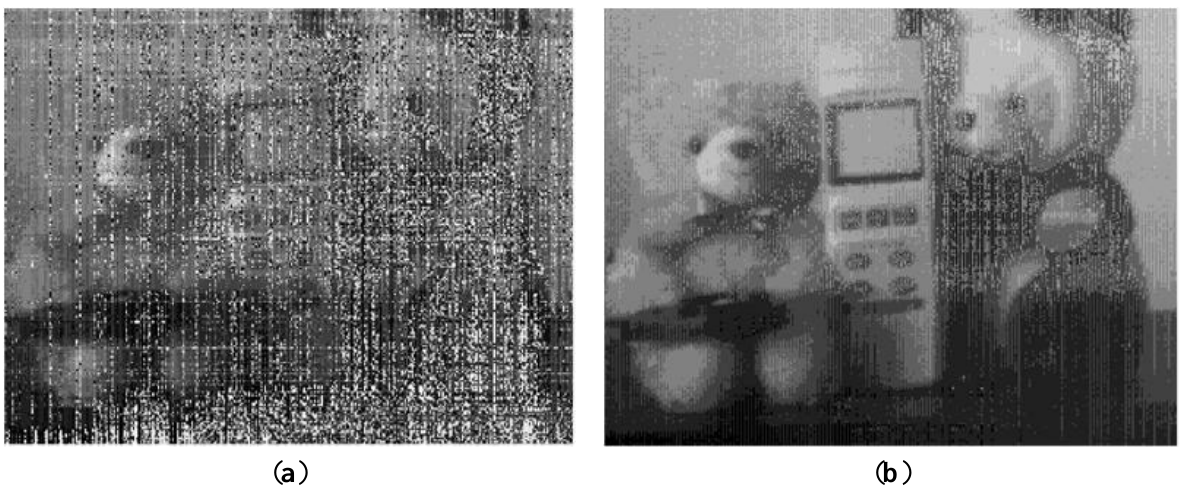
Figure 16. Measured sample image with the 1-bit coarse and 7-bit fine (14-bit resolution): ( a ) without the self-calibration; ( b ) with the